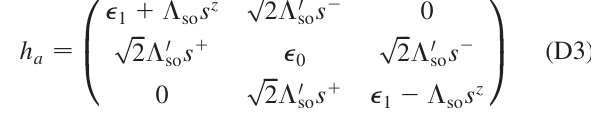
FIG. 6. Adiabatic continuity. Energy gap at the Dirac point as the Hamiltonian adiabatically deforms from the periodic adatom at (cid:2) ¼ 0 to the Kane-Mele model at (cid:2) ¼ 1 . Hamiltonian H 4 (cid:3) 4 eval- The solid blue and dashed red lines correspond to H 4 (cid:3) 4 uated with parameters appropriate for indium and thallium, respectively. In both cases, the gap remains finite as (cid:2) varies from 0 to 1, indicating that the Kane-Mele model and adatom Hamiltonian are adiabatically connected and thus support the same quantum spin-Hall (which includes only nearest-neighbor hopping and uni- form intrinsic spin-orbit coupling for graphene), we choose ¼ (cid:1) 0 : 0015 eV . As Fig. 6 illustrates, t ¼ 2 : 7 eV and (cid:2) so the Dirac-point gap computed for H ð (cid:2) Þ indeed remains finite for all (cid:2) between 0 to 1 with either indium (solid blue line) or thallium (dashed red line) parameters input into H . The QSH state known to be supported by H 4 (cid:3) 4 KM